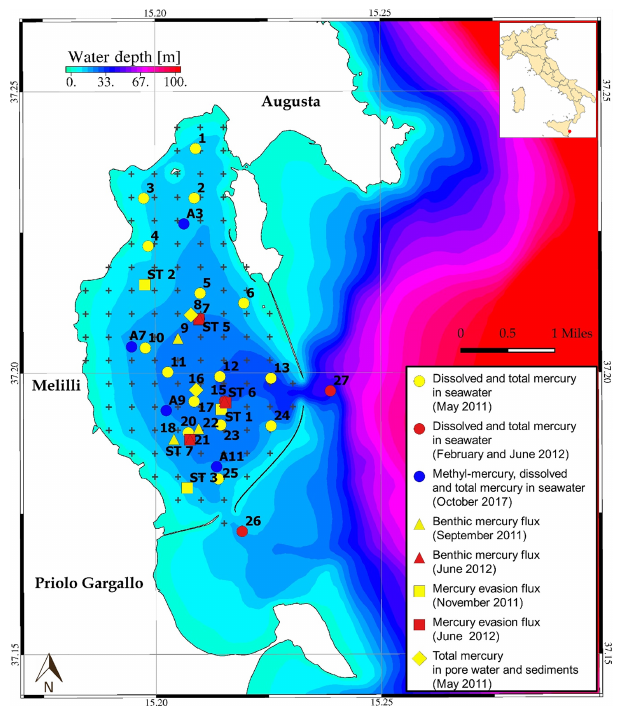
Figure 1. Map of the area under investigation including the Au- gusta Bay and the eponymous harbor. The sampling sites of each oceanographic survey are indicated with different symbols.